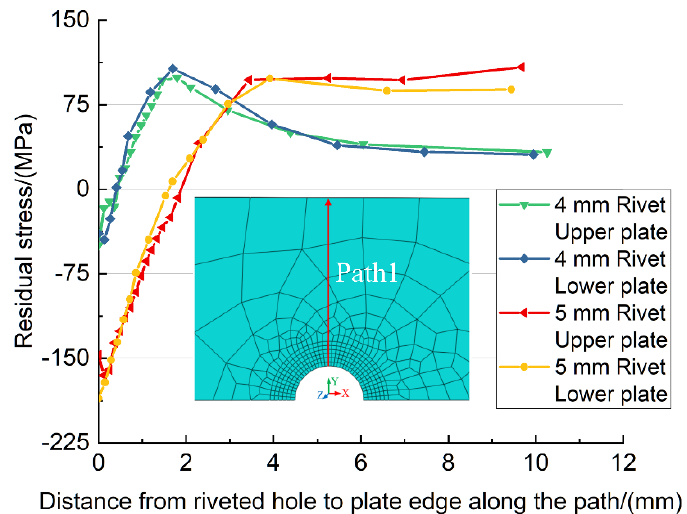
Figure 13. The residual stress along the path from the riveted hole to plate edge.